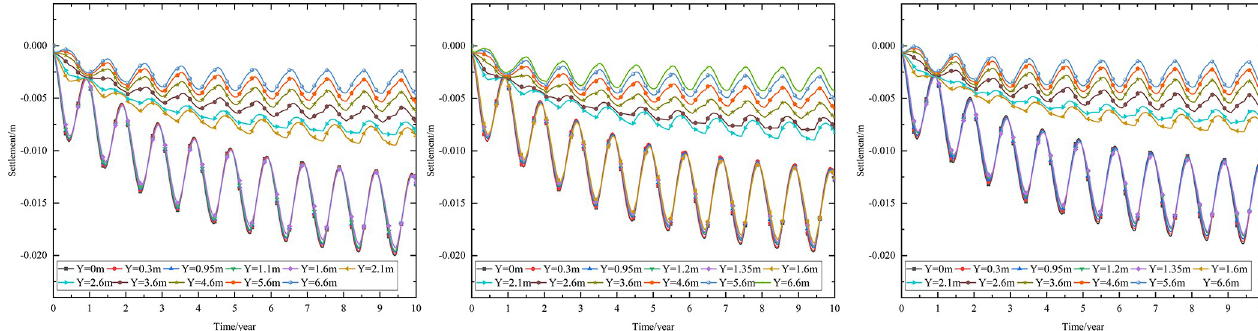
Fig 20. Settlement-time curves of pavement center under the static load of the aircraft with the installation layer at (a) the top of the subbase layer, (b) the middle of the subbase layer, and (c) the bottom of the subbase layer.